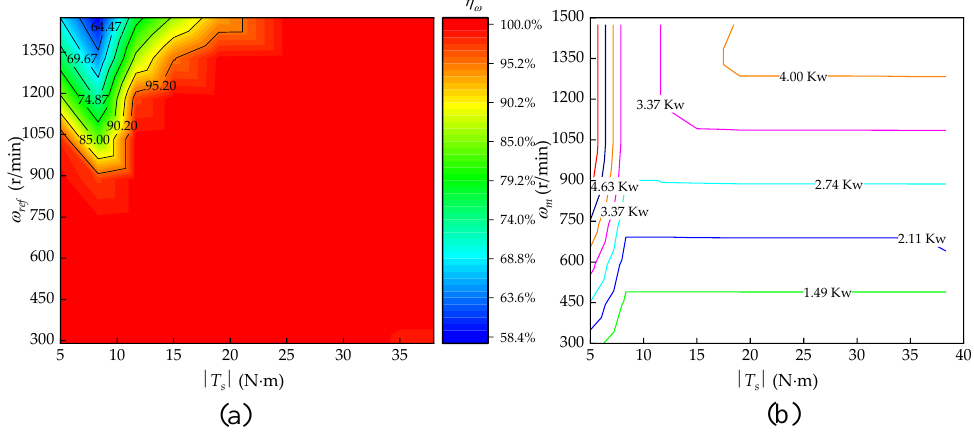
Figure 10. ( a ) Speed accuracy map for T-CBV system, ( b ) power consumption map for T-CBV system.